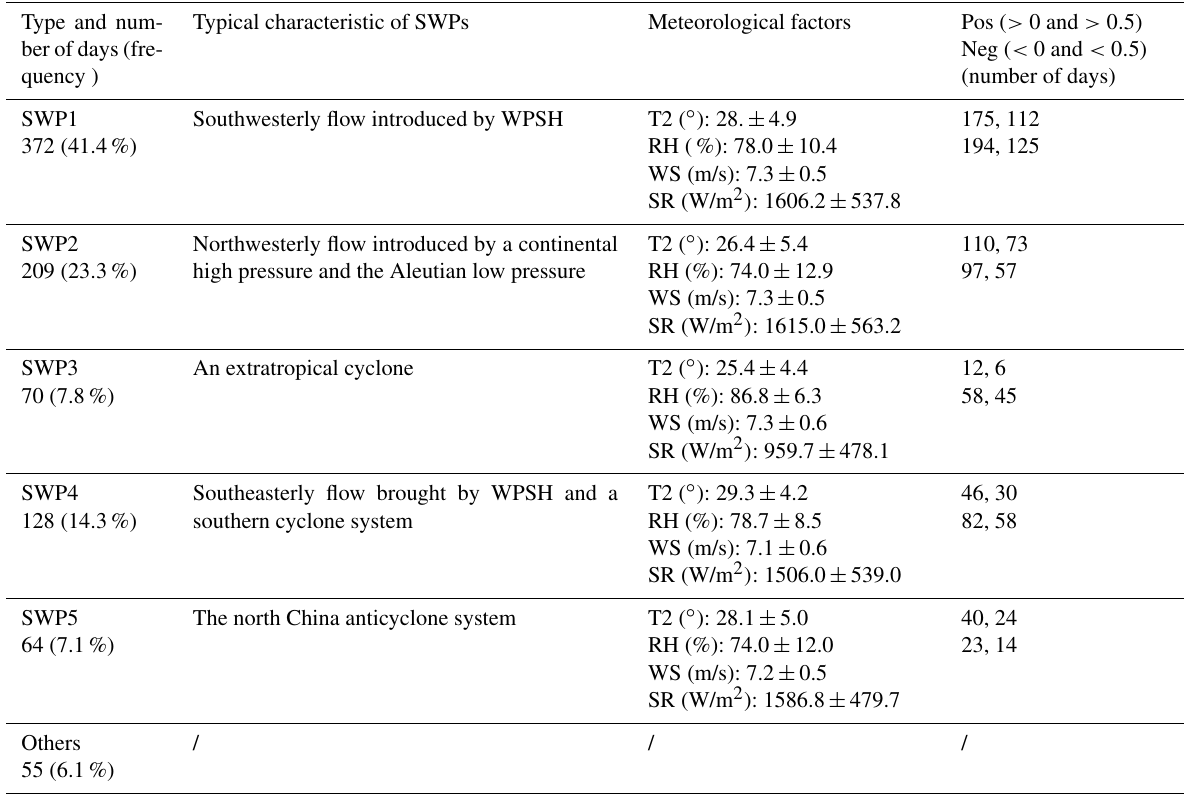
Table 1. The occurrence days and frequency, typical characteristics, regional mean ± the standard error for T2, RH, WS and SR and positive and negative days under each SWP. The > 0 and > 0 . 5 represent the value of EOF1 time series more than 0 and 0.5, respectively. The < 0 and < 0 . 5 show the